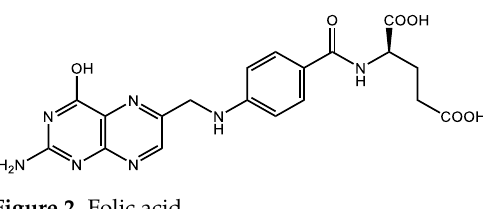
Figure 2. Folic acid.